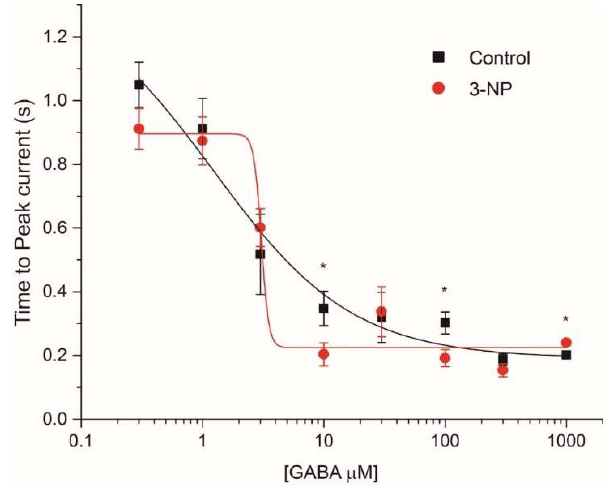
Figure 5. Time to peak of the GABA current. The activation time of I GABA was different only for GABA concentrations of 10 µM, 100 µM, and 1000 µM (F 7, 15 =69.36, p < 0.05, Two ways ANOVA).* p < 0.05